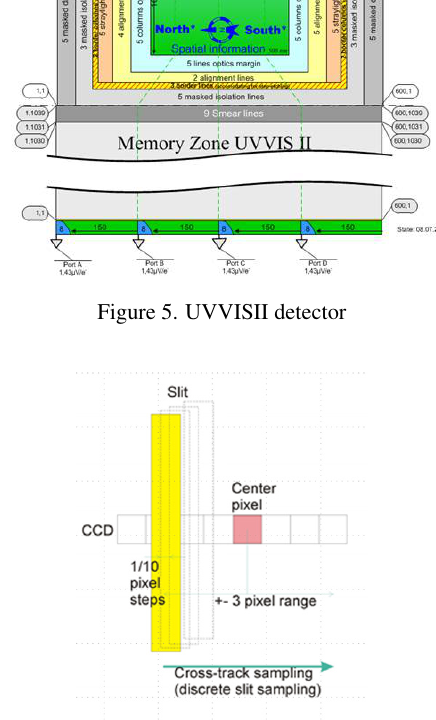
Figure 6. Measurement